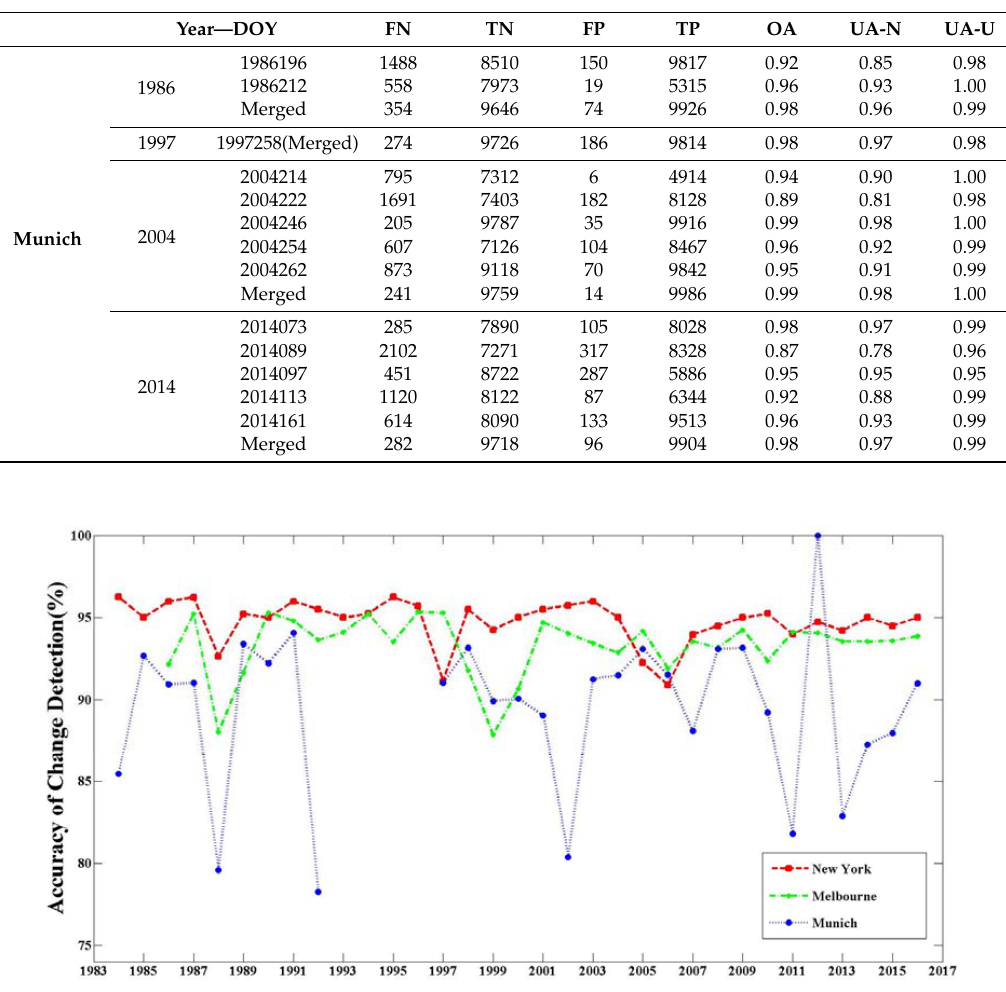
Figure 8. Time series of change detection accuracy for New York, Melbourne, and Munich during